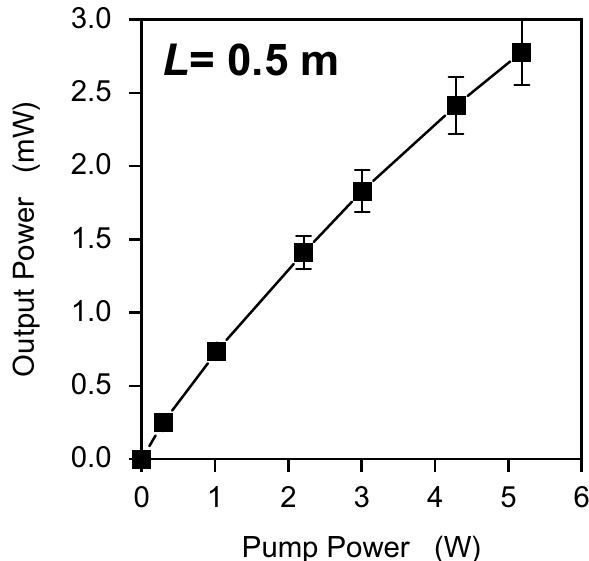
Figure 5. Output power of ASE source as a function of pump power.